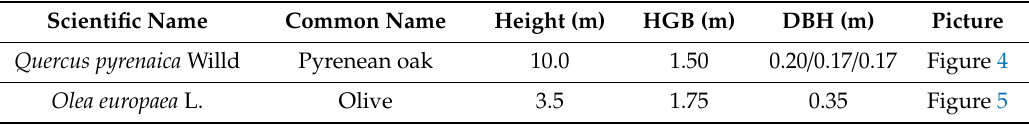
Figure 5. A photograph of the Olea europaea L. tree taken at 5:30 p.m. under direct sunlight. Table 2. Characteristics of sample trees. Scientific Name Figure 5 HGB: Height from the ground (collar) to where branches begin (bifurcation); DBH: diameter at breast height. 3. Methodology The tree inspection was carried out applying qualitative IRT at the passive mode, that is, the heat source was the environment through solar radiation. The heat flows from the hotter to the colder zones of the tree. The irregularities of the thermal pattern on the tree surface can indicate the existence of defects, voids and deteriorated tissue. When it is found, deterioration as voids and defects occur in both the thermal properties of the constituents and the heat transfer process [2–5,7]. Thermograms were recorded at different times along the day, from when direct solar radiation was hitting the trees until after sunset. Besides the thermograms, photographs were taken to support the visual inspection and thermogram interpretation. The thermograms were processed running FLIR software [23,24]. The authors marked the spots at different locations over the tree trunk. The thermal patterns were analysed in order to correlate the temperature distribution with tree health. The atmospheric temperature and the relative humidity were measured at the time of the recording pf each thermogram, as well as the observation distance (between the thermal camera and the tree).